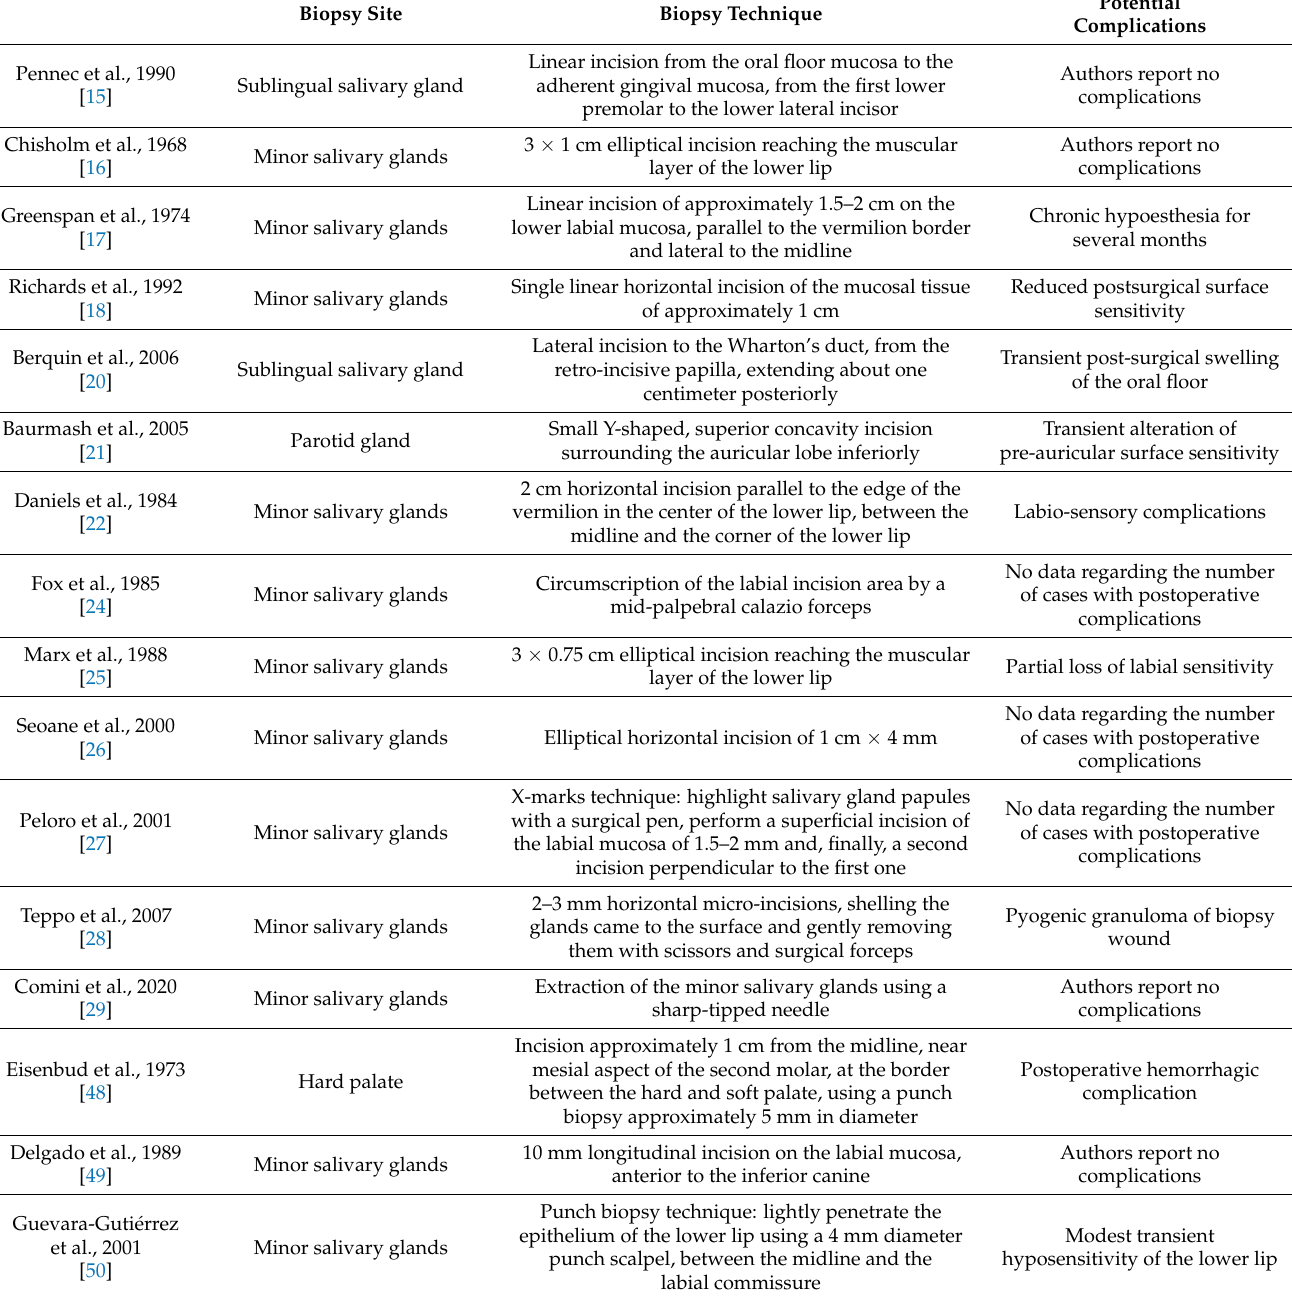
Table 3. Summary table of the main open biopsy techniques of the major and minor salivary